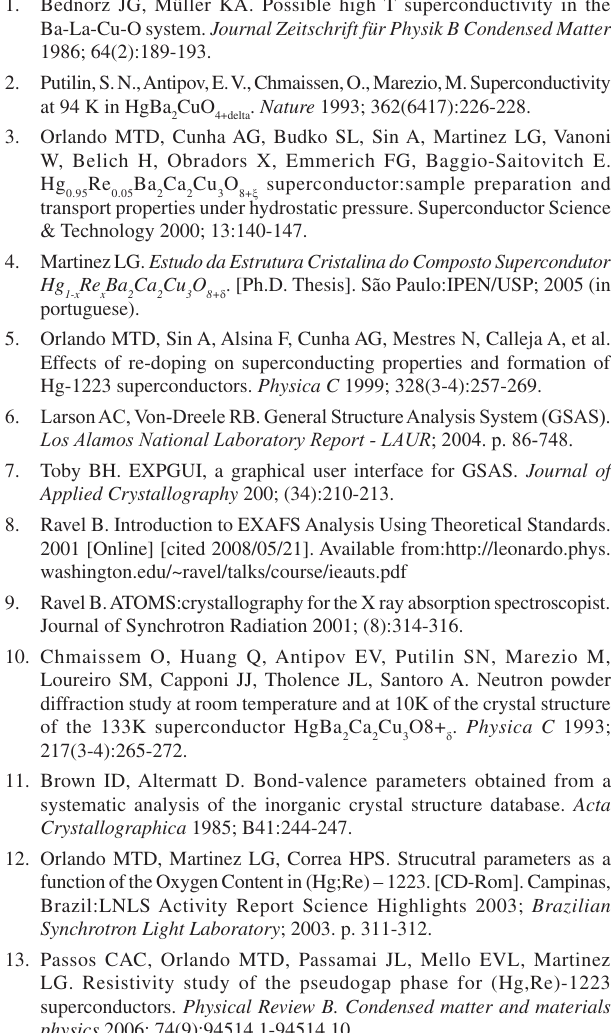
Figure 4. Rietveld plot and corresponding calculated unit cell for sample